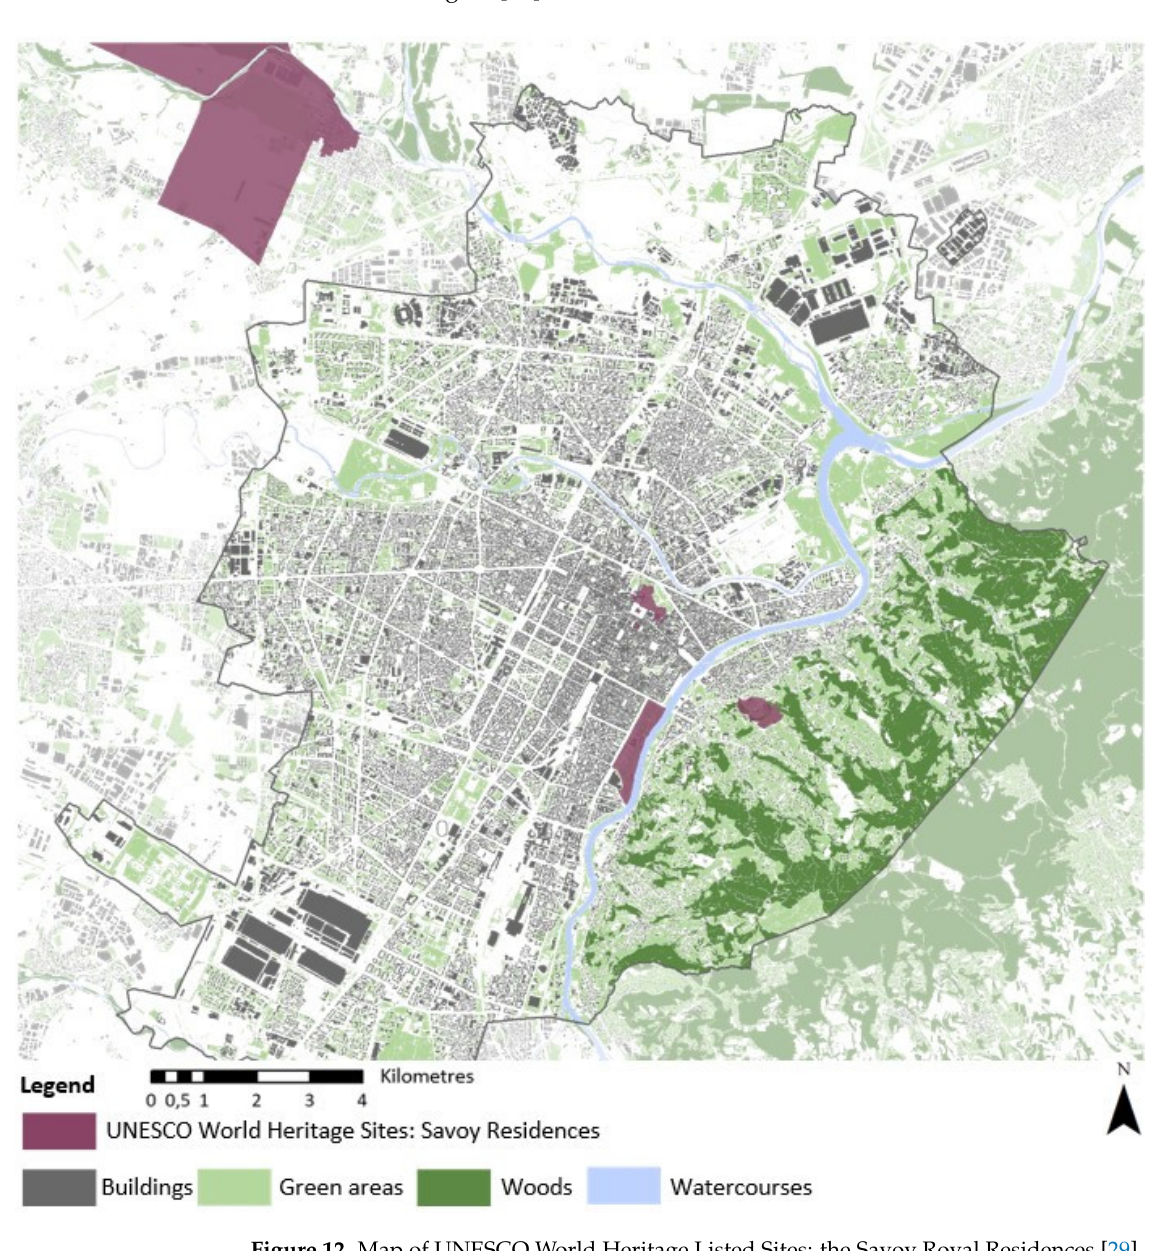
Figure 12. Map of UNESCO World Heritage Listed Sites: the Savoy Royal Residences [29].